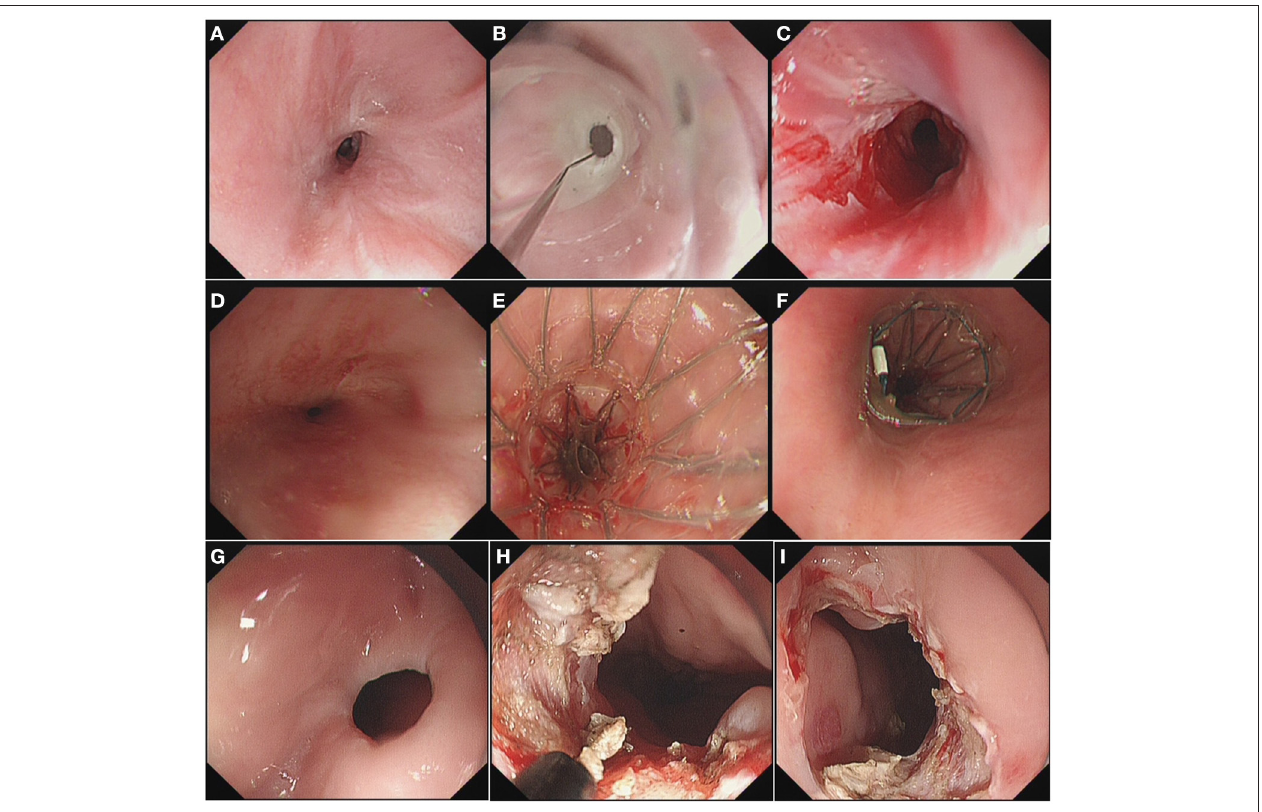
FIGURE 1 | (A) Endoscopy Image of the stenosis before EBD. (B) EBD procedure. (C) Enlarged diameter of the stenosis after EBD. (D) Endoscopy Image of the stenosis before endoscopic stent placement. (E) Insertion of the stent. (F) Observation of the upper margin of the stent. (G) Endoscopy Image of the stenosis before EI. (H) Radial incisions under endoscopy. (I) Enlarged diameter of the stenosis after